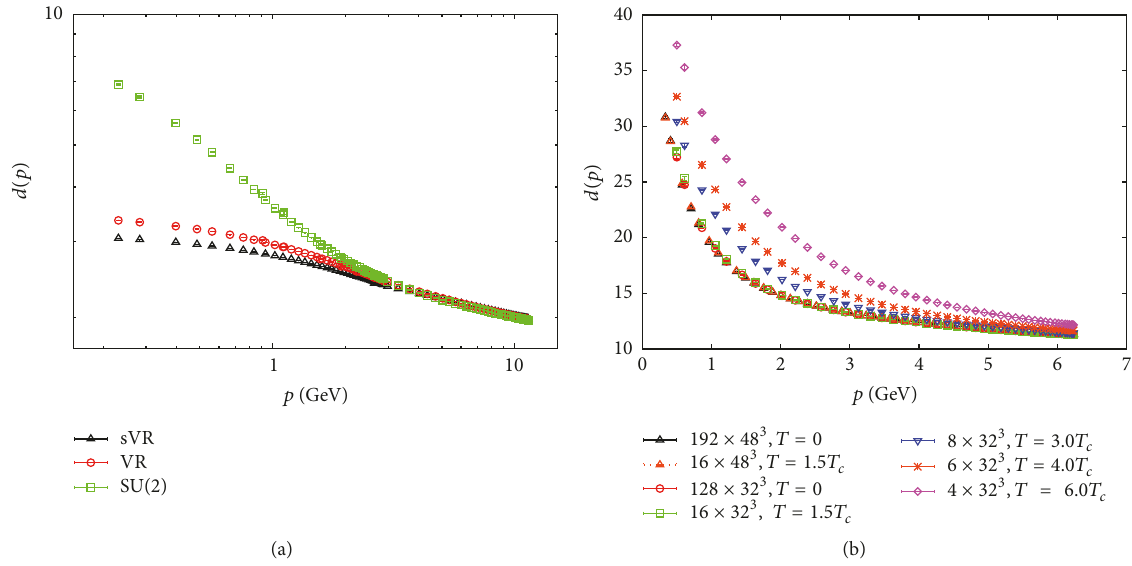
Figure 6: (a) The ghost form factor in Coulomb gauge calculated on the lattice in [29] (green squares). The red circles and black triangles show the results obtained for the ghost form factor when all center vortices or only the spatial center vortices are removed from the ensemble of gauge field configurations; see main text. (b) Ghost form factor calculated on the lattice for different temperatures.